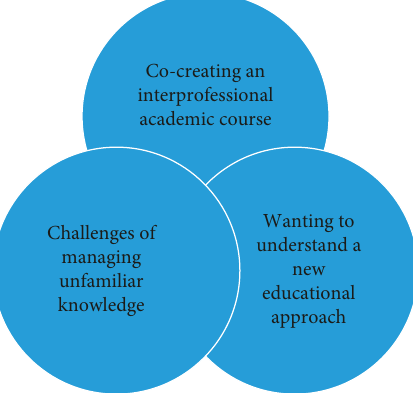
Figure 2: The categories generated by the